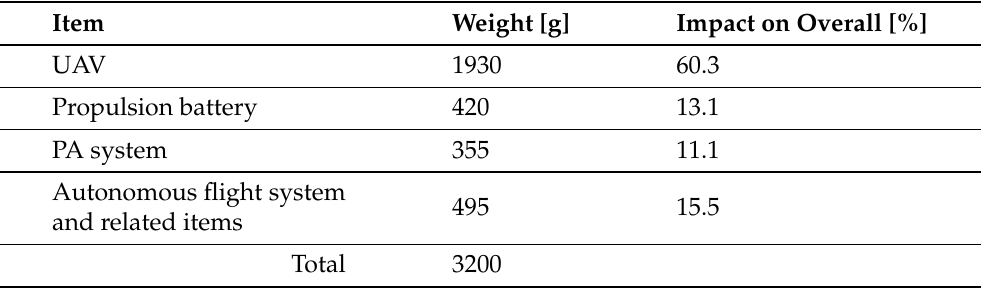
Table 3. Impact of items on the overall weight.